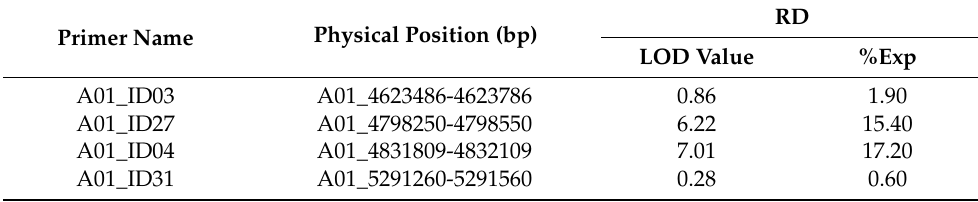
Table 3. QTL mapping analysis of the FR1.1 locus with the polymorphic markers.